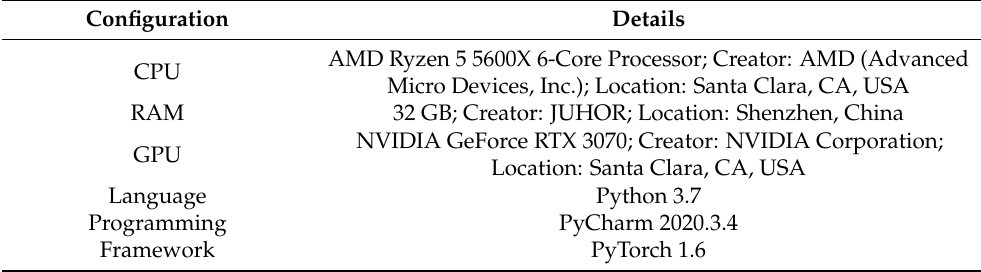
Figure 7. The data input of the RIAU-Net model, where C 12 _real and C 12 _imag denote the real and imaginary part of C 12 . Table 3. The hardware and software configurations for the experiments.